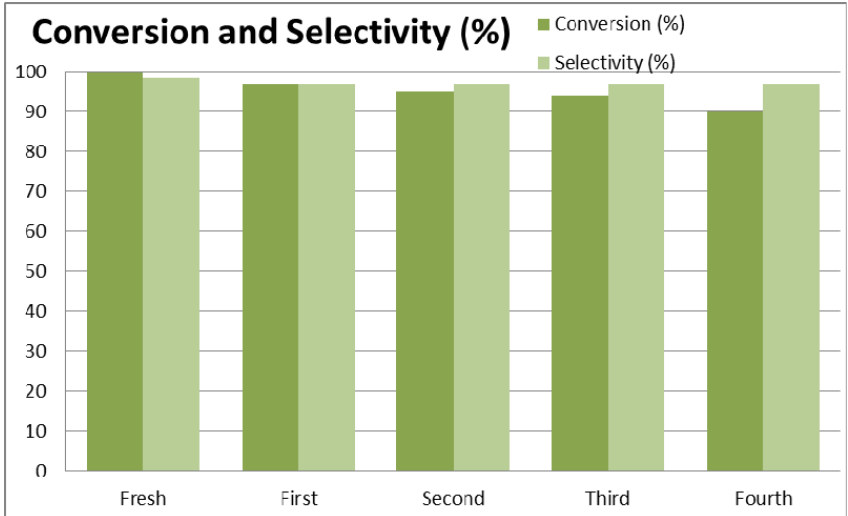
Figure 1. Cycling performance of MK10 in synthesis of 1-benzyl-2-phenyl-benzimidazole 1a under MW irradiation.